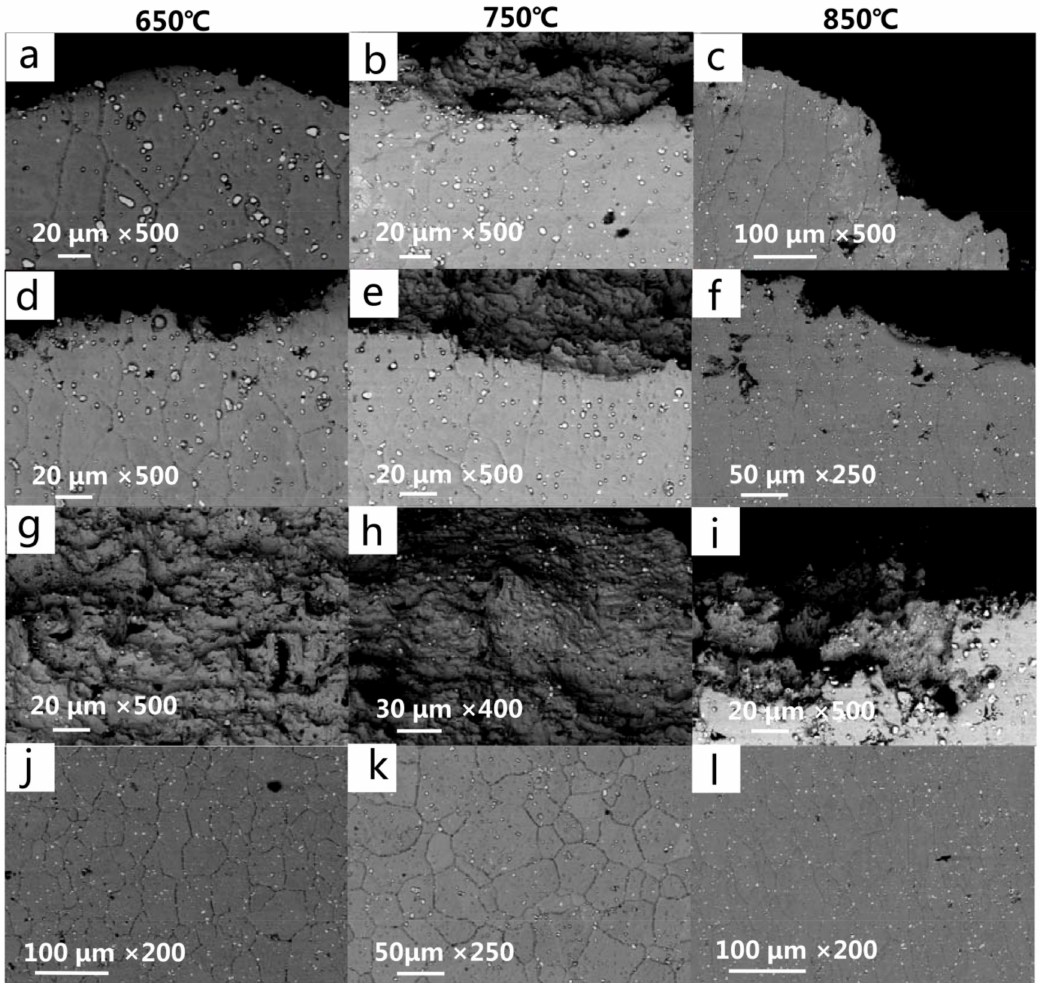
Figure 8. Fracture morphology at 650 ◦ C / 750 ◦ C / 850 ◦ C. ( a – c ) Inclined fracture view of the surface of the plate with overflow holes and ( d – f ) the surface of the plate with impact holes; ( g – i ) fracture surface morphology and ( j – l ) microstructure near the fracture